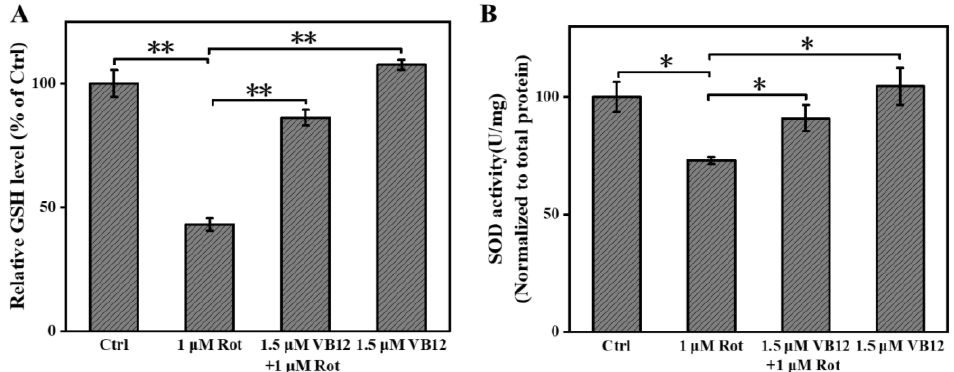
Figure 3. VB12 restored the reductant level of Rot-treated SH-SY5Y cells. ( A ) GSH content. ( B ) SOD content. Data are the mean ± SEM, n = 3. * p < 0.05, ** p < 0.01 compared with other groups.